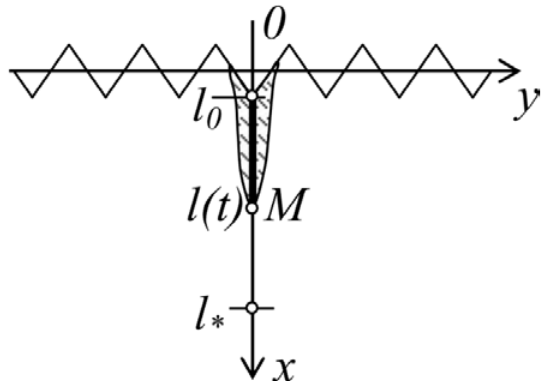
Fig. 1. Coordinate system and a model of crack propagation deep into the layered coating